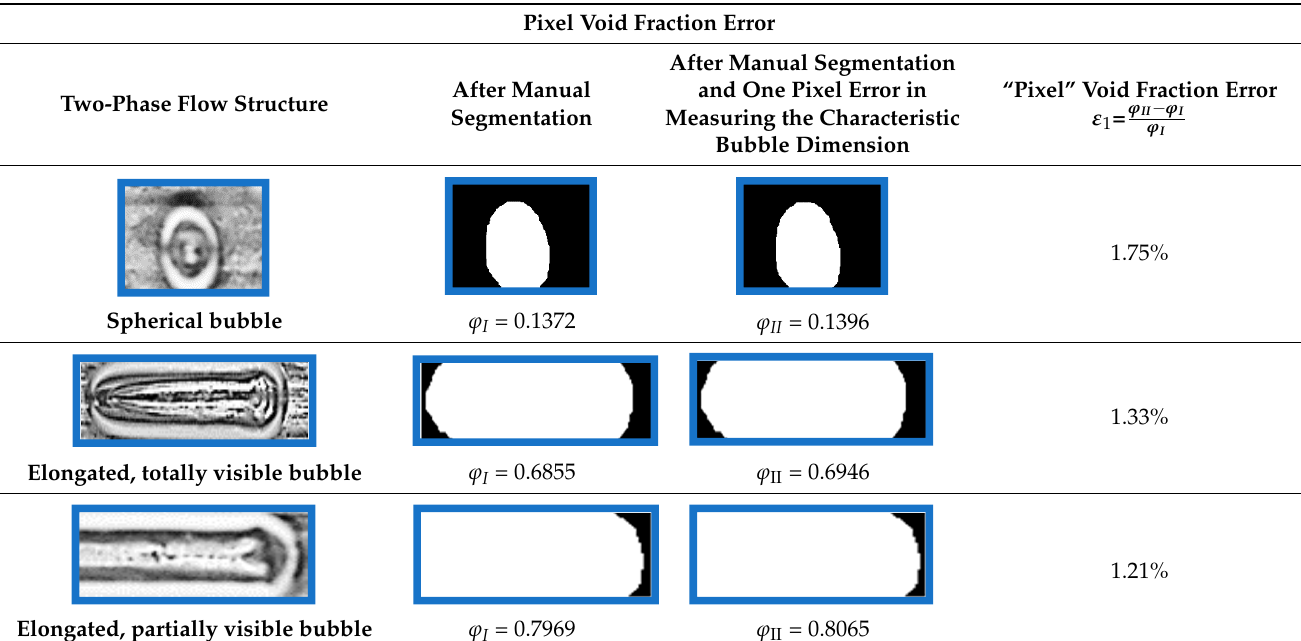
Table 2. Local void fraction error resulting from one pixel error in measuring the characteristic dimension of the detected bubble.